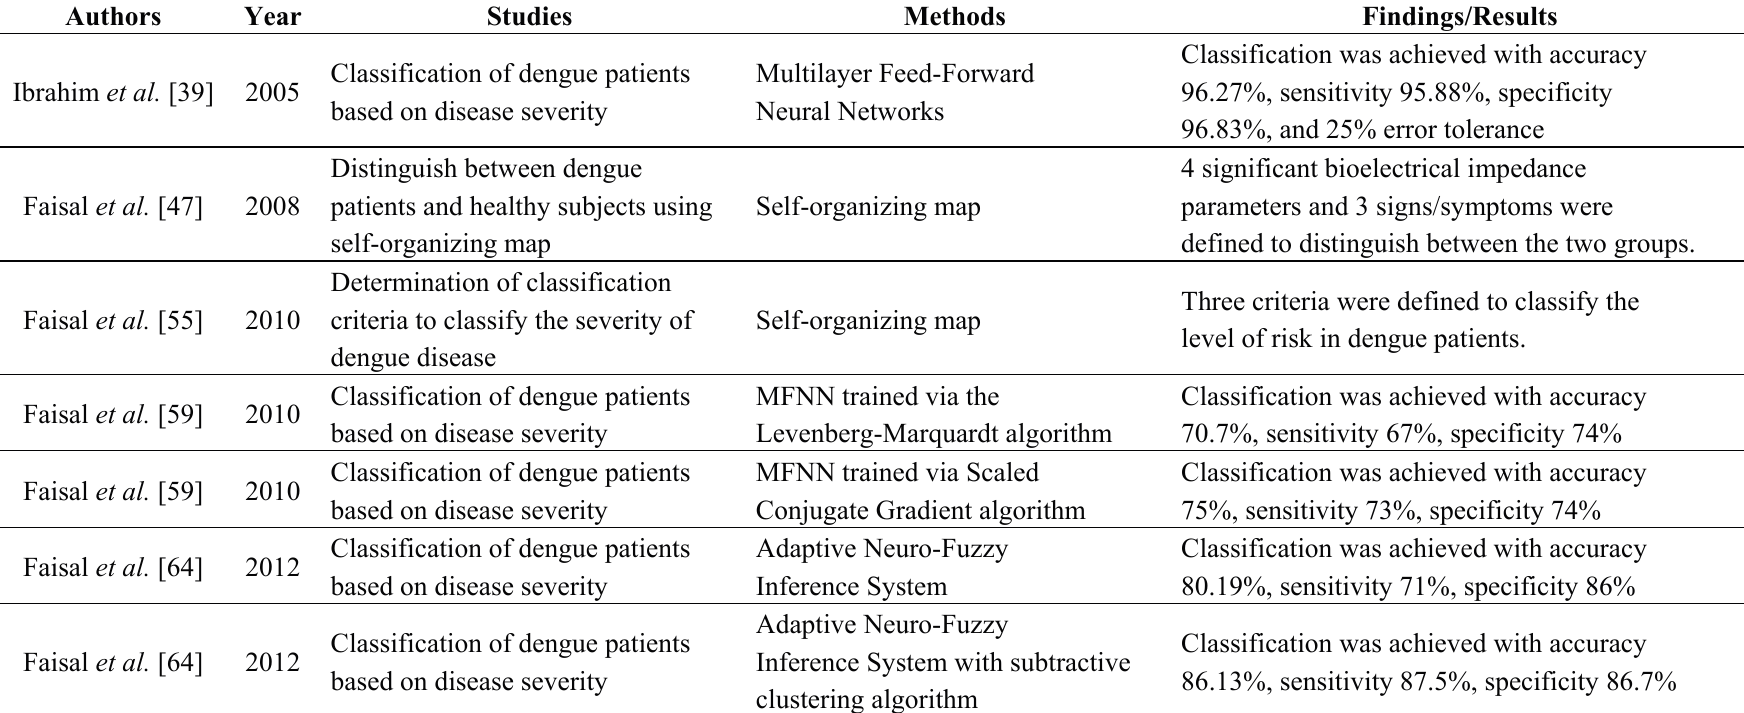
Table 3. Summary of biomedical engineering techniques in in dengue clinical decision support